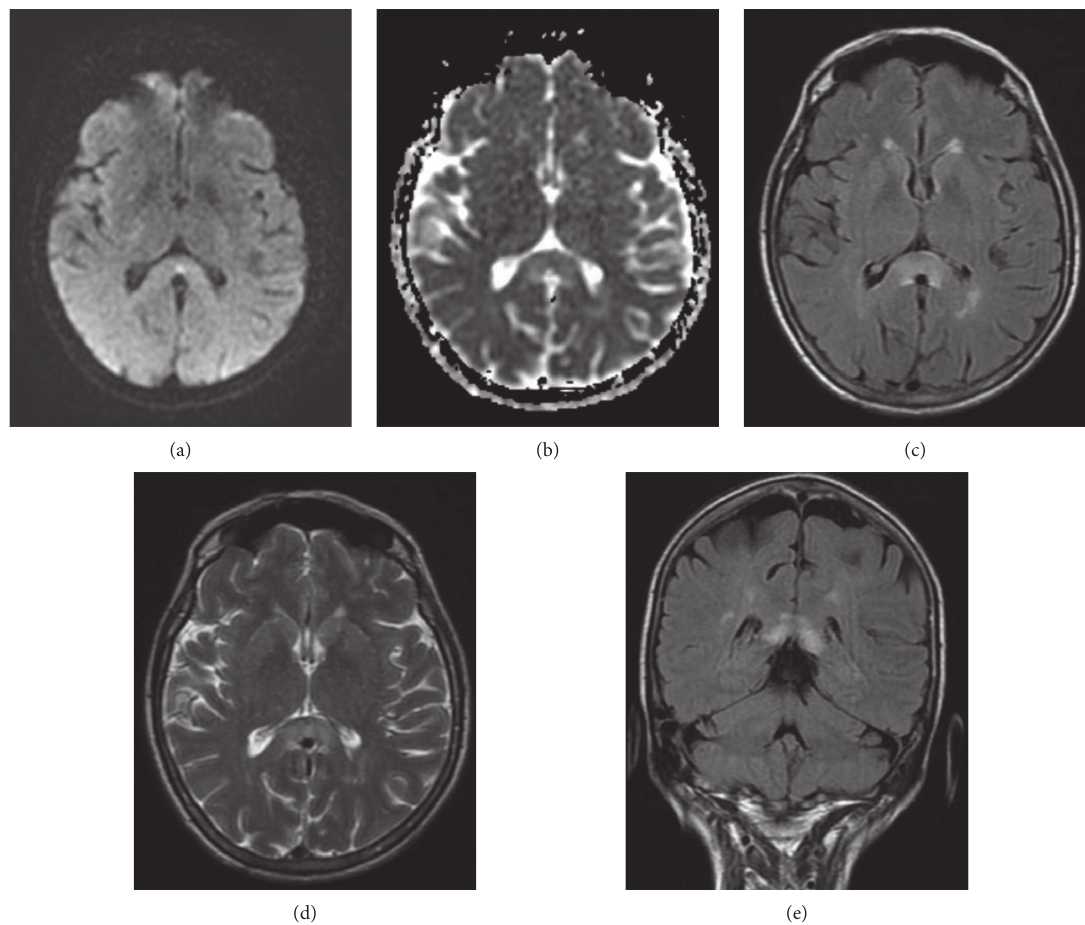
Figure 1: MR brain with and without contrast on admission. (a) DWI, axial cut. (b) ADC axial cut. (c) FLAIR axial cut. (d) T2 axial cut. (e) FLAIR coronal cut. Imaging reveals hyperintensity in the splenium of the corpus